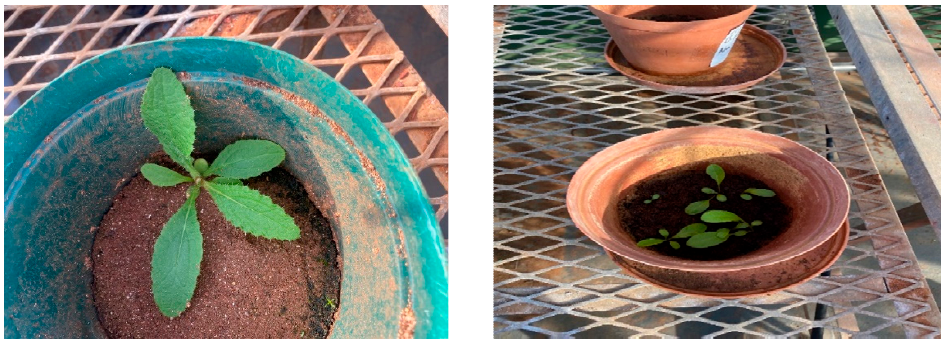
Figure 3. B. radula seedlings (90 d.a.p.) from Serpentine 2 ( left ) and control ( right ). Table 3. Correlation coefficients among developmental parameters, photosynthetic efficiency and heavy metals and macronutrients in B. radula leaves, with significant relations among each other. GR = growth rate, LC = leaf count, LL = leaf length, BM = biomass. * Significant ( p < 0.05).